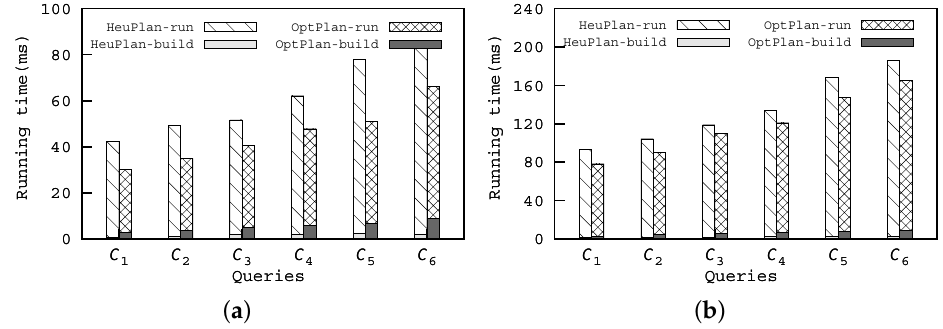
Figure 7. Cost analysis for tree-based execution plan. ( a ) Source Codes. ( b ) Medline.